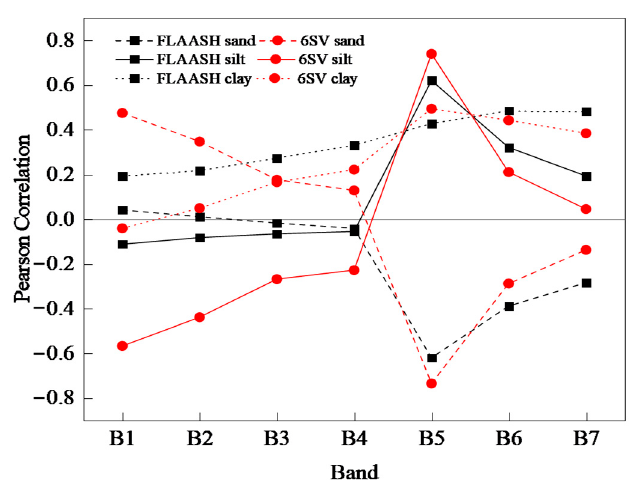
Figure 7. Correlation between soil particle-size content in different thickness and reflectance spectra of ( a ) FLAASH atmospheric correction model and ( b ) 6SV atmospheric correction model.